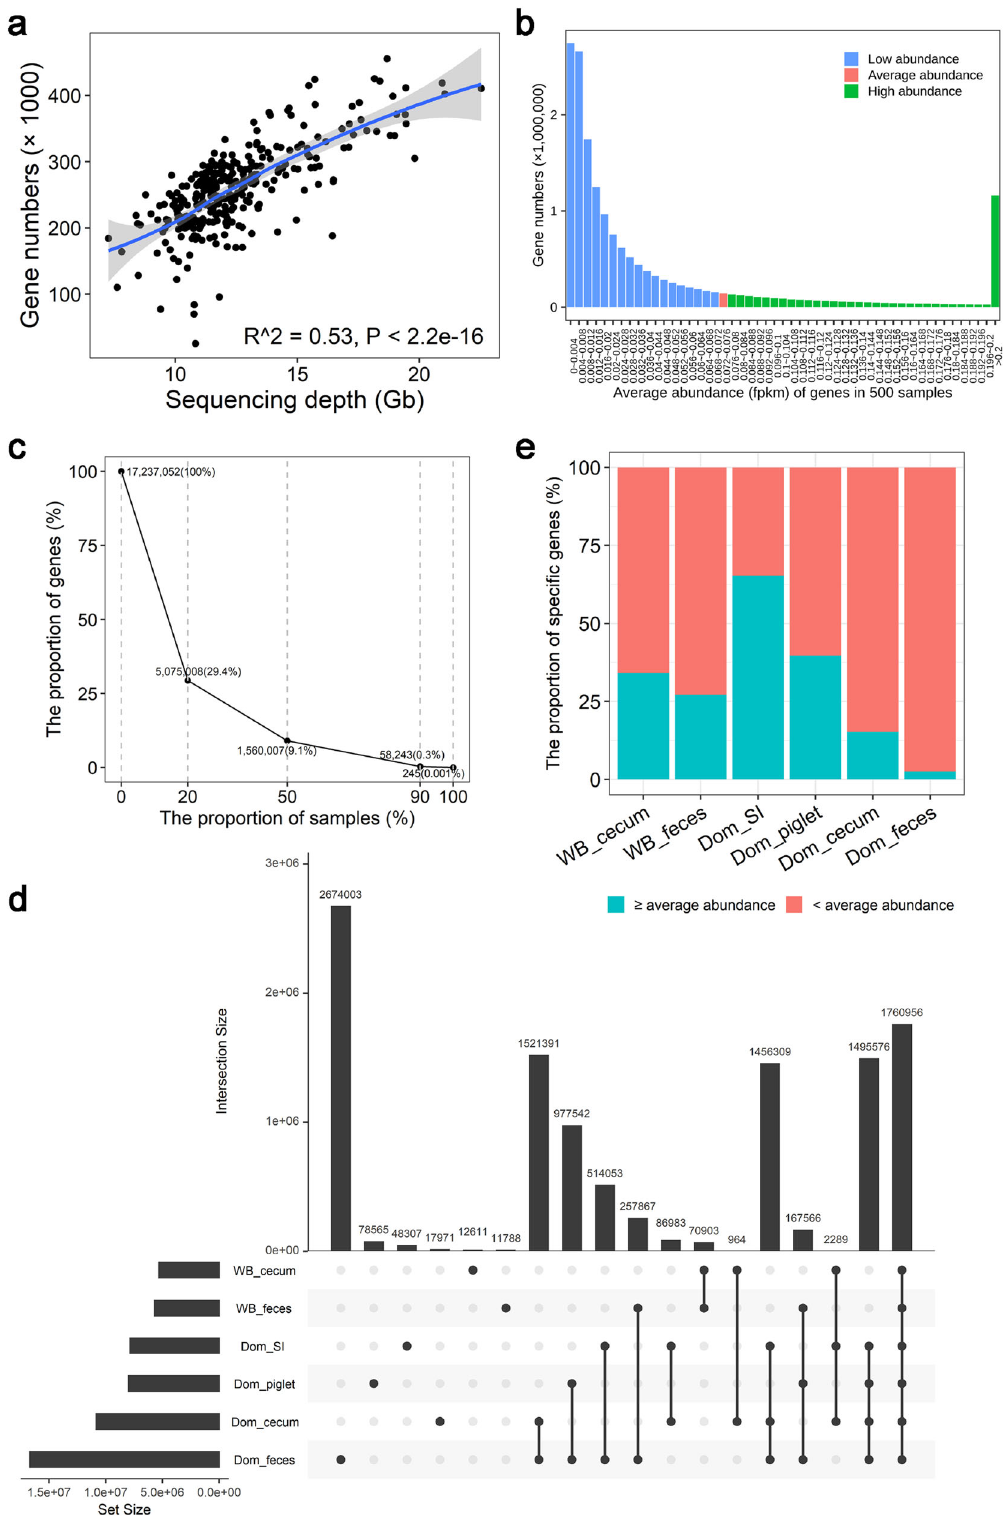
bacterial taxa detected in more than 90% of the tested samples were de fi ned as the core bacteria of pig gut microbiome and 19 (50% in all annotated phyla) phyla, 234 (33%) genera, and 254 (20%) species were identi fi ed as core bacteria. Among these, 15 phyla, 135 genera, and 97 species were detected in all 500 samples (Fig. 3a). The abundances of these 97 species occupied more